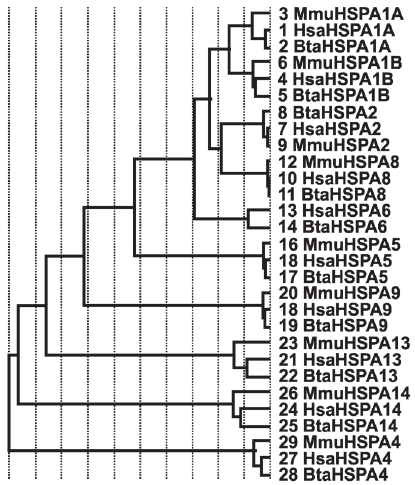
Figure 7. Sequence identity dendrogram of heat shock protein 70 gene family members. The first three letters Hsa, Bta and Mmu corresponds to human, bovine and mouse, respectively. The numbers represent the sequence numbers used in the evolutionary analysis.